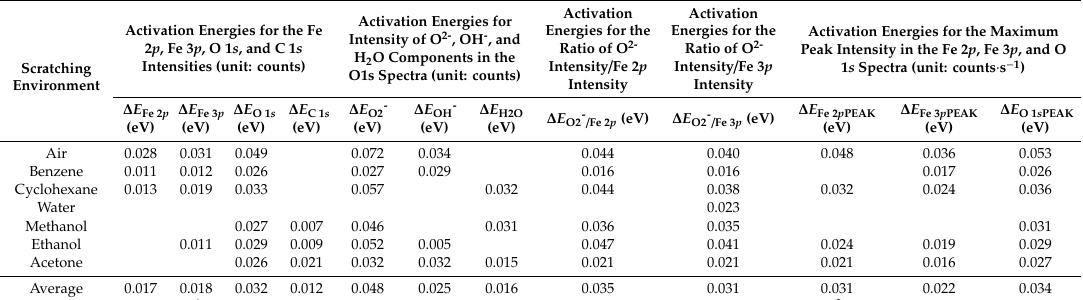
Table 4. Arrhenius activation energies obtained from the XPS data at 25, 200, and 339 ◦ C for the iron surfaces scratched in the di ff erent environments a), b) .